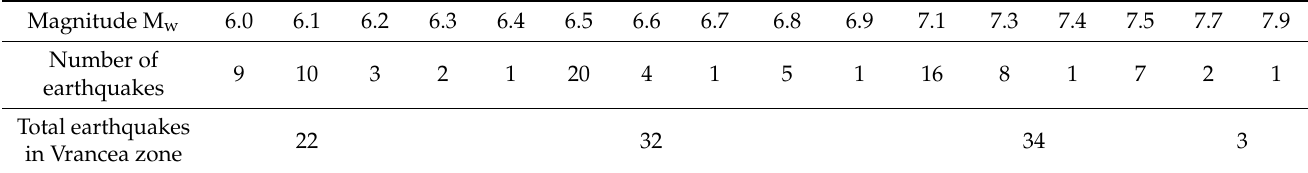
Table 2. The distribution of the events with a magnitude moment ≥ 6 that occurred in Vrancea zones (a total number of 91 earthquakes).